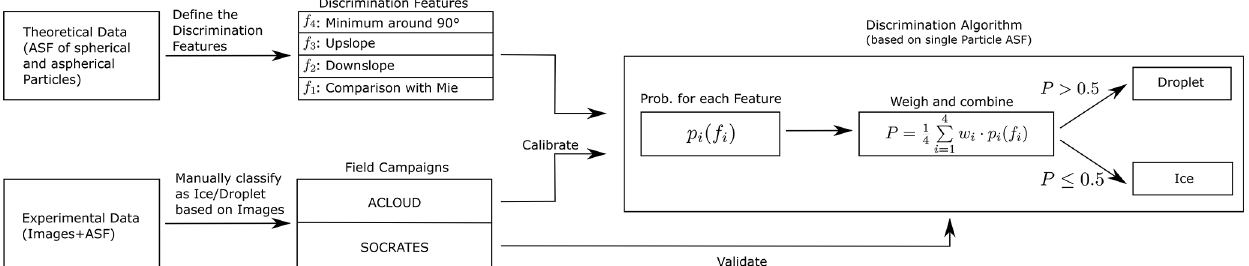
Figure 3. Schematics showing the basic working principle of the phase discrimination algorithm.